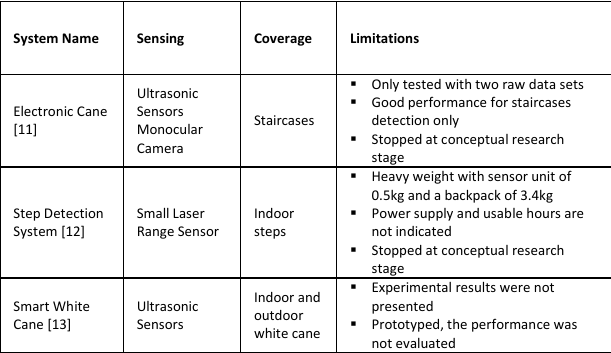
Table 1. Electronic-based Ground Plane Conditions